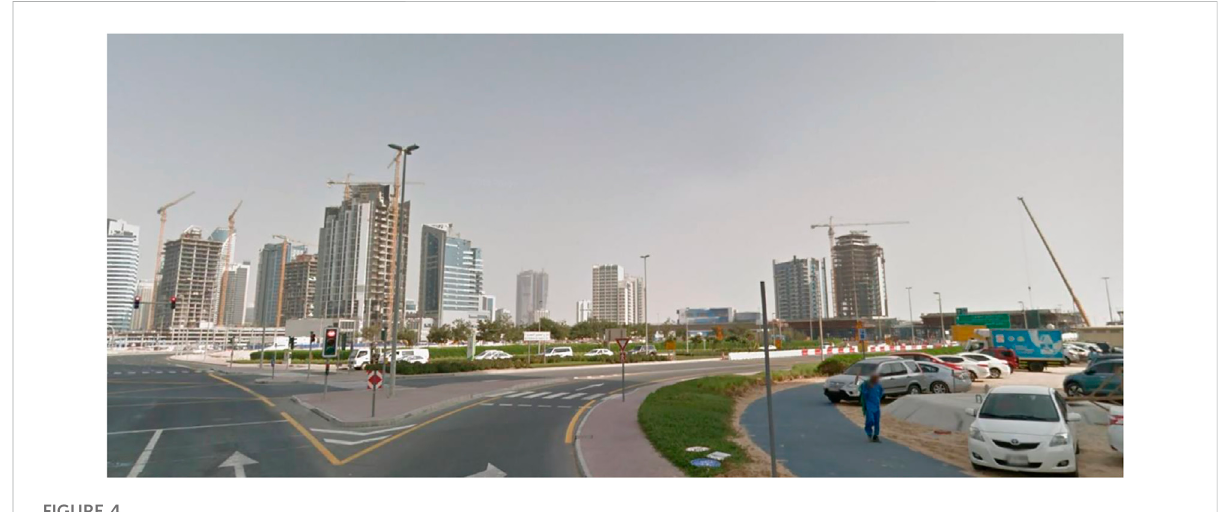
FIGURE 4 Urban context of U-bora tower at business